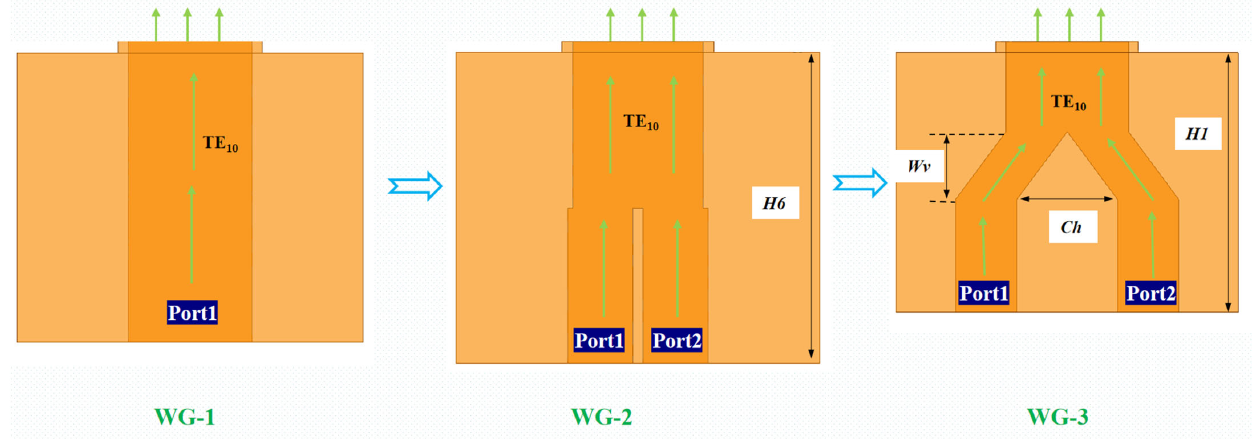
Figure 5. The evolution of the geometric design of the curved waveguide.